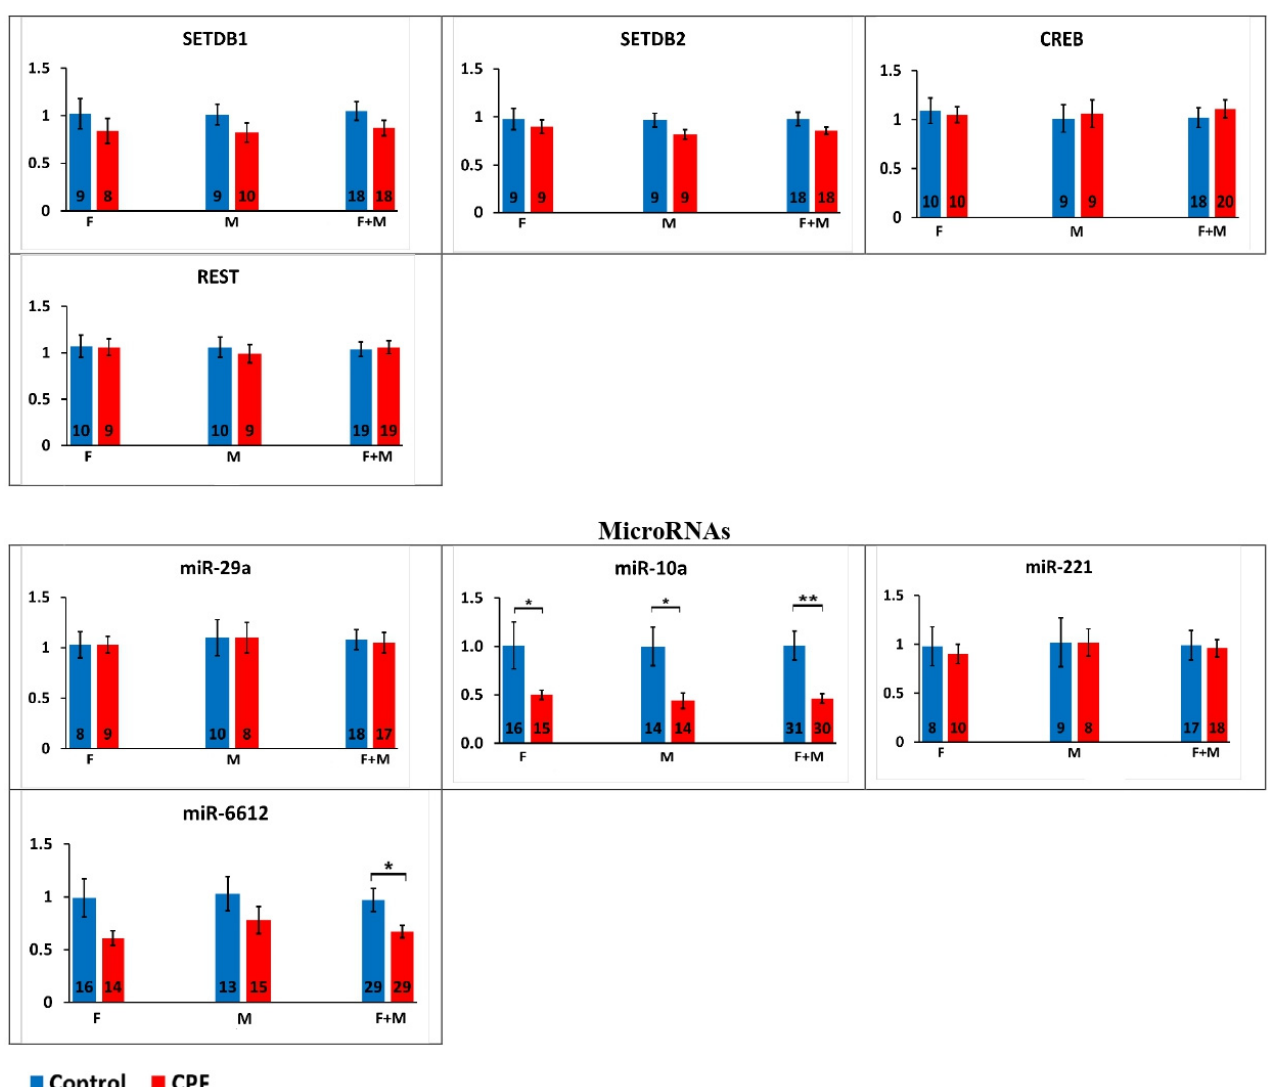
Figure 1. Effects of paternal exposure to chlorpyrifos (CPF) on the offspring’s gene expression. Relative gene expression results obtained in the offspring after paternal exposure to chlorpyrifos. M: male offspring, F: female offspring. Number of samples (n) is presented inside each column. Results are presented as the mean ± SEM. #: PKCß, which is related to both neurogenesis and neurotransmission genes, is presented in the neurotransmission section. *: p < 0.05, **: p < 0.005 and ***: p < 0.0005. PKCß: protein kinase C beta, BDNF: brain-derived neurotrophic factor, FOS: C-Fos, DCX: doublecortin, CHRM2 and CHRM3: muscarinic receptors 2 and 3, SLC18A3: solute carrier family